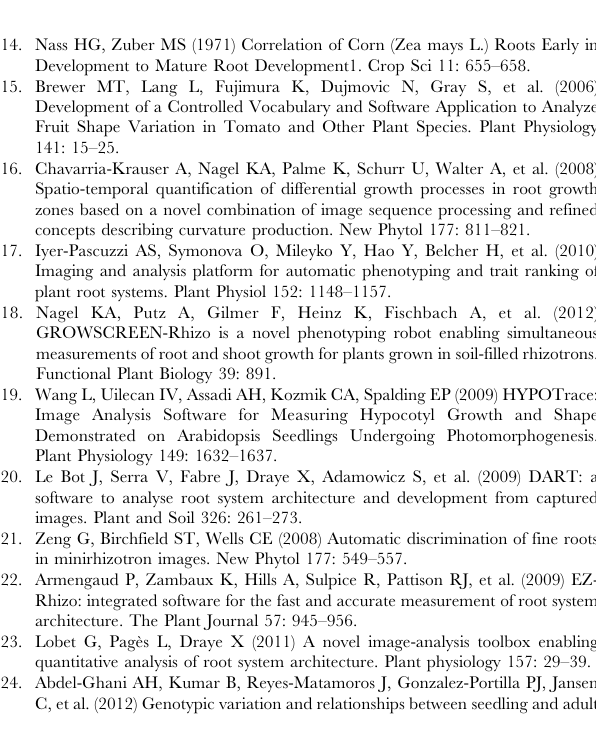
Table S1 Trait correlations between all 28 traits extracted using ARIA . Non-significant correlations denoted with ‘*’. Table S2 Simple statistics for all traits collected by